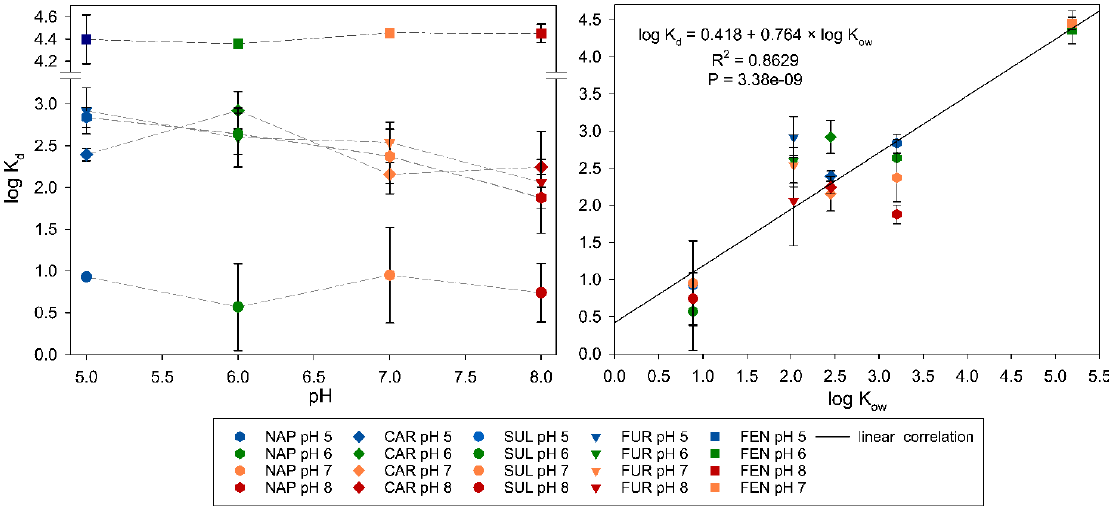
Figure 3. Partitioning coefficients (log K d ) versus pH of the sediment-water system and the octanol-water partitioning coefficient (log K ow ) of the substances.